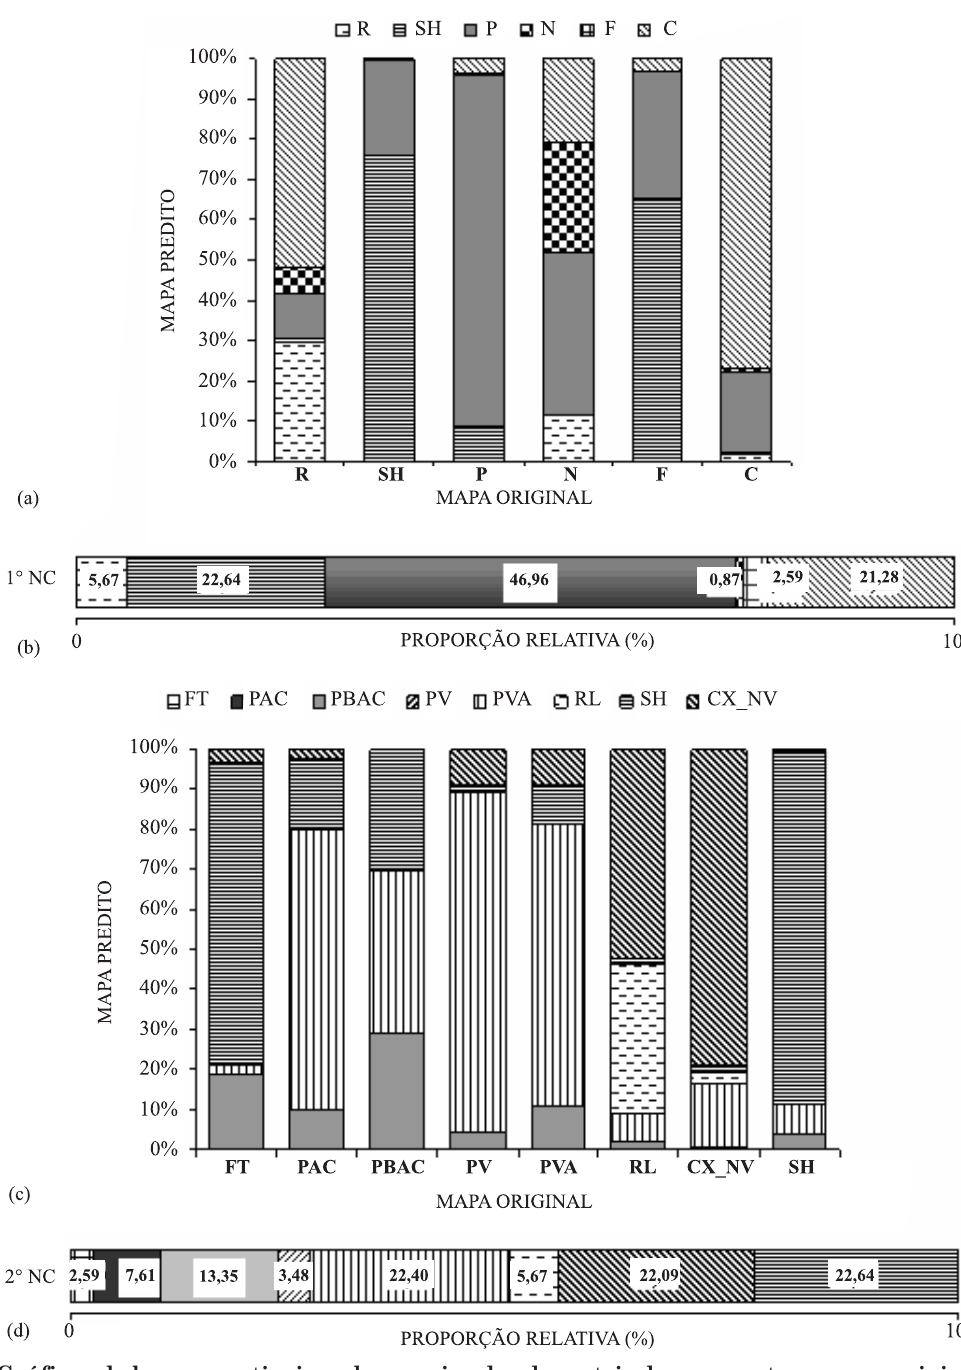
Figura 4. Gráficos de barras verticais: valores oriundos da matriz de erros entre o mapa original e o mapa predito no 1° Nível Categórico (a) e no 2° Nível Categórico (c). Gráficos de barras horizontais: proporção relativa de cada classe de solos no conjunto total de 70.000 amostras utilizadas para gerar os modelos no 1° Nível Categórico (b) e no 2° Nível Categórico (d). Cambissolo (C), Neossolo (R), Solos Hidromórficos (SH), Argissolo (P), Nitossolo (N), Plintossolo (F), associação Cambissolo Háplico e Nitossolo Vermelho (CX_NV), Argissolo Vermelho (PV), Solos Hidromórficos (SH), Neossolo Litólico (RL), Argissolo Vermelho- Amarelo (PVA), Argissolo Acinzentado (PAC), Argissolo Bruno-Acinzentado (PBAC) e Plintossolo Argilúvico (FT). Nível Categórico